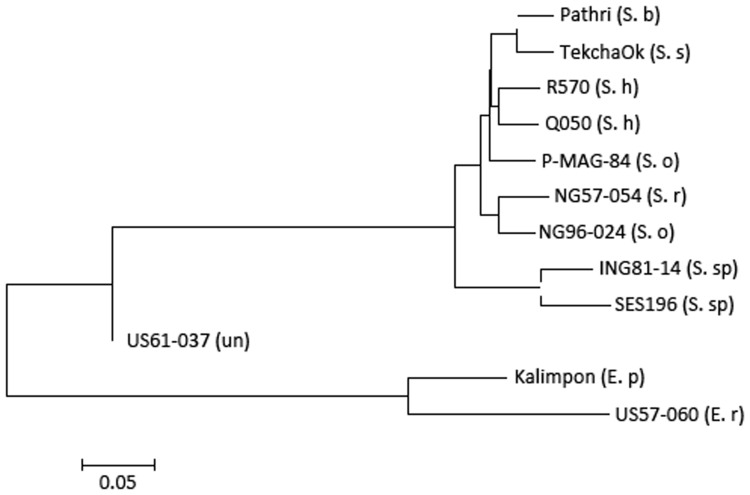
Phylogenetic tree of the 12 accessions generated using biallelic- single nucleotide polymorphism of the 12 accessions.